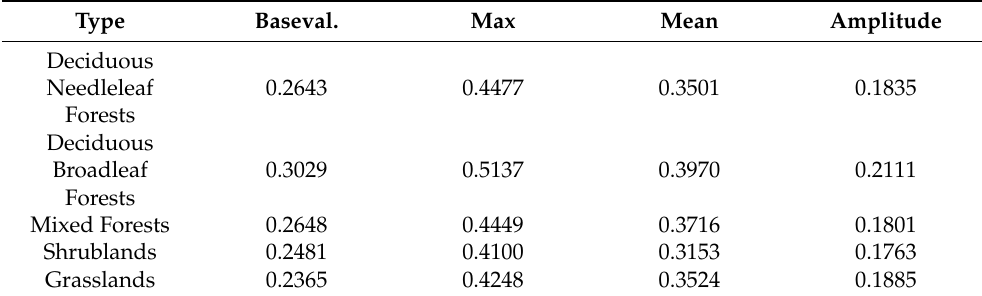
Table 5. Typical land cover phenological parameters.